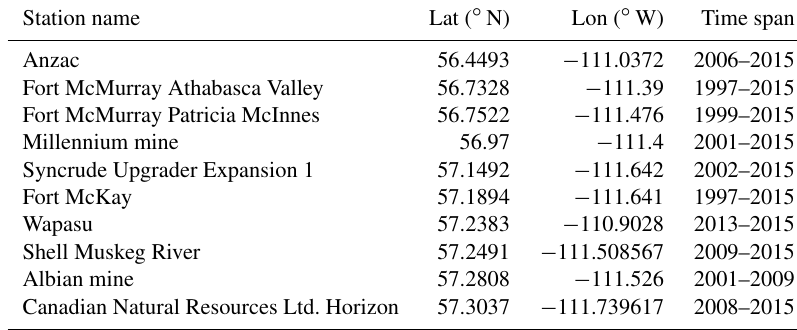
Table 2. Selected NAPS PM 2 . 5 sites and time span of available data (inclusive).